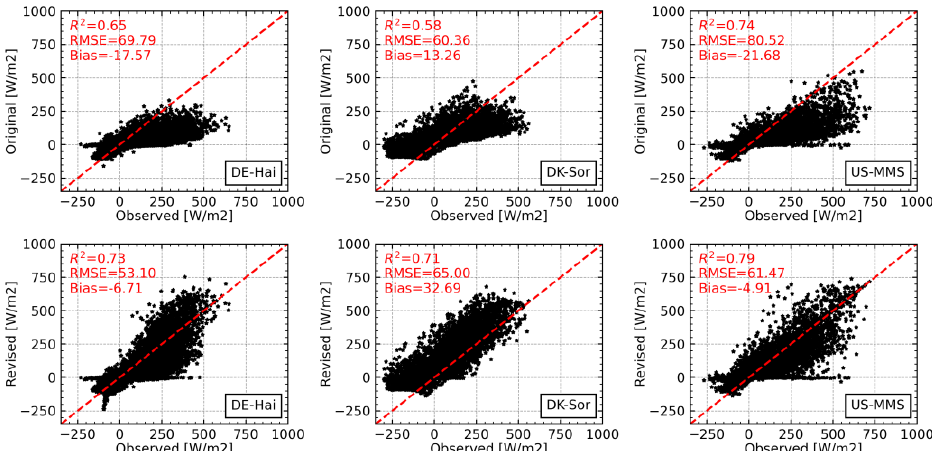
Figure 5. Relationship between the observed and simulated sensible heat flux by the original and revised parameterization at Deciduous Broadleaf Forest (DBF) sites. the revised parameterization at Deciduous Broadleaf Forest (DBF) sites.